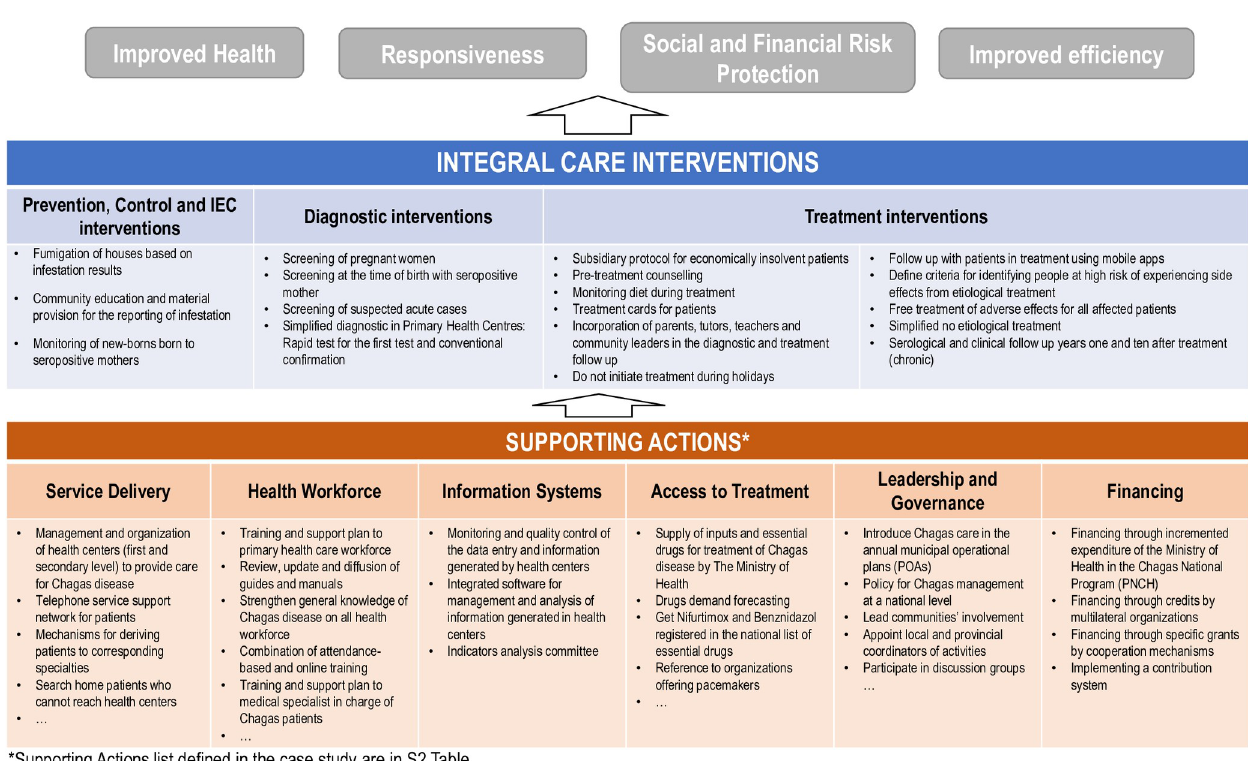
Fig 1. Model to evaluate Interventions and